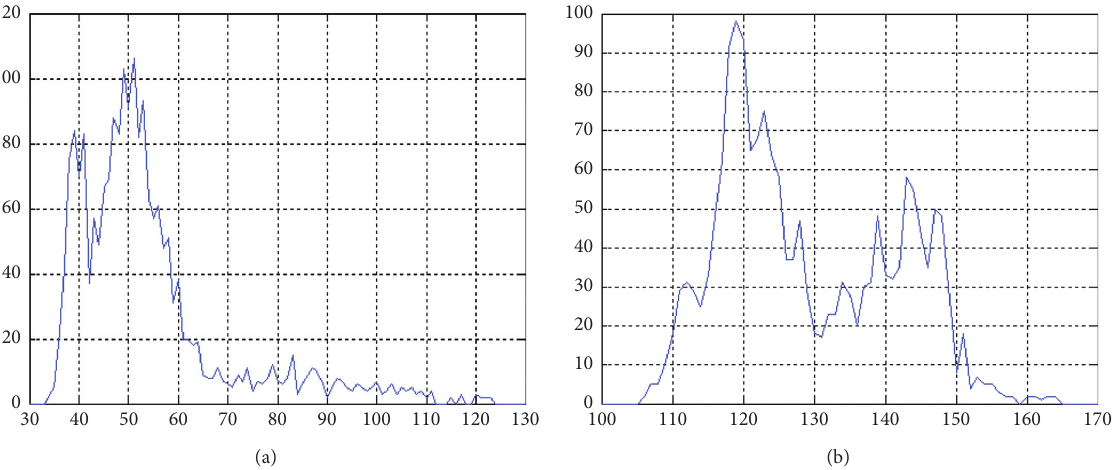
Figure 4: Comparison of RSSI difference. (a) The distance is 30 cm ( X : RSSI value; Y : frequency of occurrence). (b) The distance is 1m ( X : RSSI value; Y : frequency of occurrence).